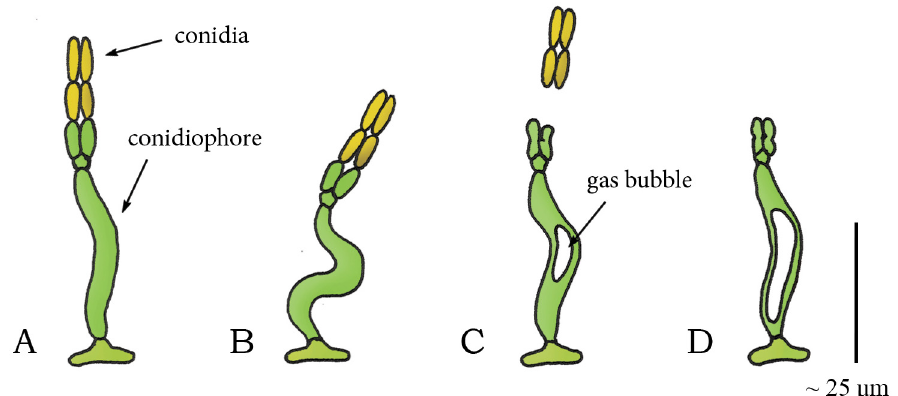
Fig 7. Cavitation catapult mechanism in Zygophalia jamaicensis . (A) Conidiophore of Z . jamaicensis with two divergent conidia at its apex. (B) S-shaped compression of the conidiophore by drying. (C) When a critical negative pressure (compared to ambient) is reached, the sudden appearance of the gas bubble in the conidiophore releases the stored elastic energy in the cell walls and discharges the conidia from the sporogenous cells. (D) Conidiophore after discharge. Drawings based on schematic drawings in [61]. Scale bar 25 μ m.